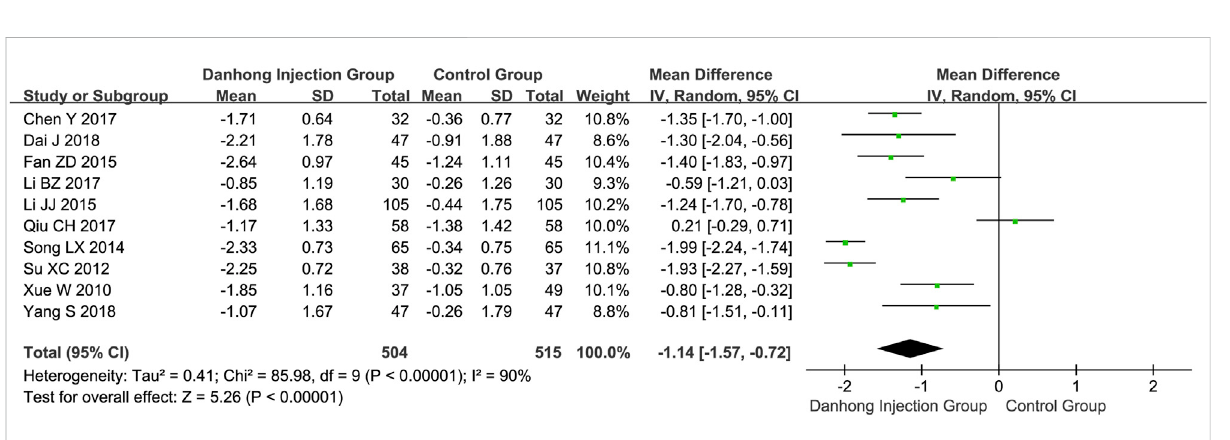
FIGURE 4 Meta-analysis of total cholesterol between DHI + WM and WM in patients with ischemic stroke.